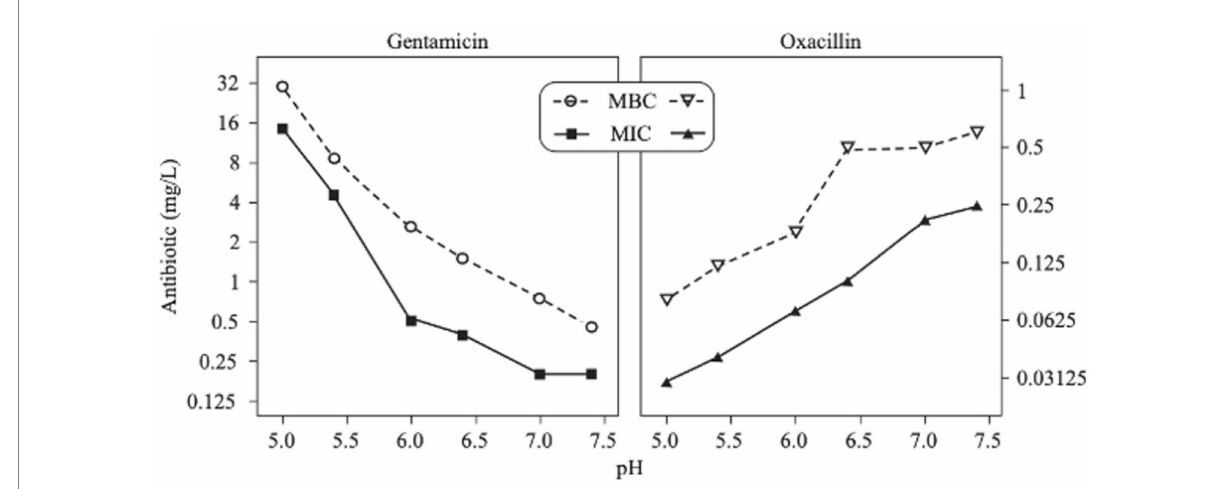
FIGURE 9 MICs and MBCs of two antibiotics (gentamicin and oxacillin) as a function of pH on S. aureus (Baudoux et al.,